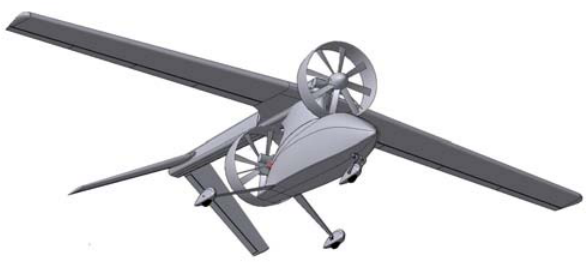
Fig. 3. General view of the twin-engine UAV equipped with variable thrust vector